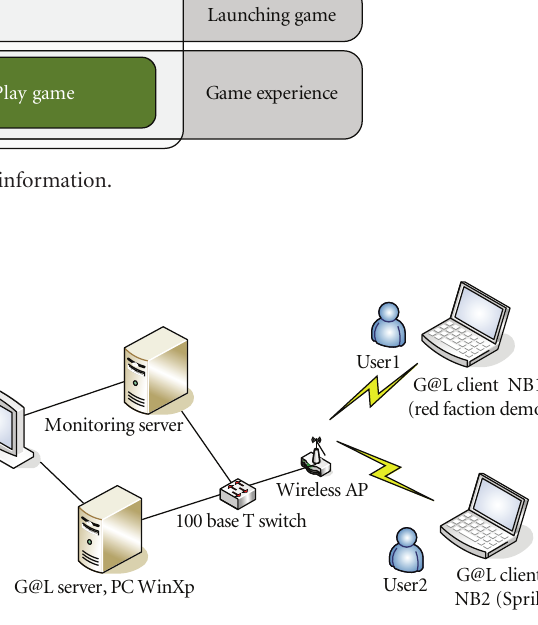
Figure 8: Games@Large